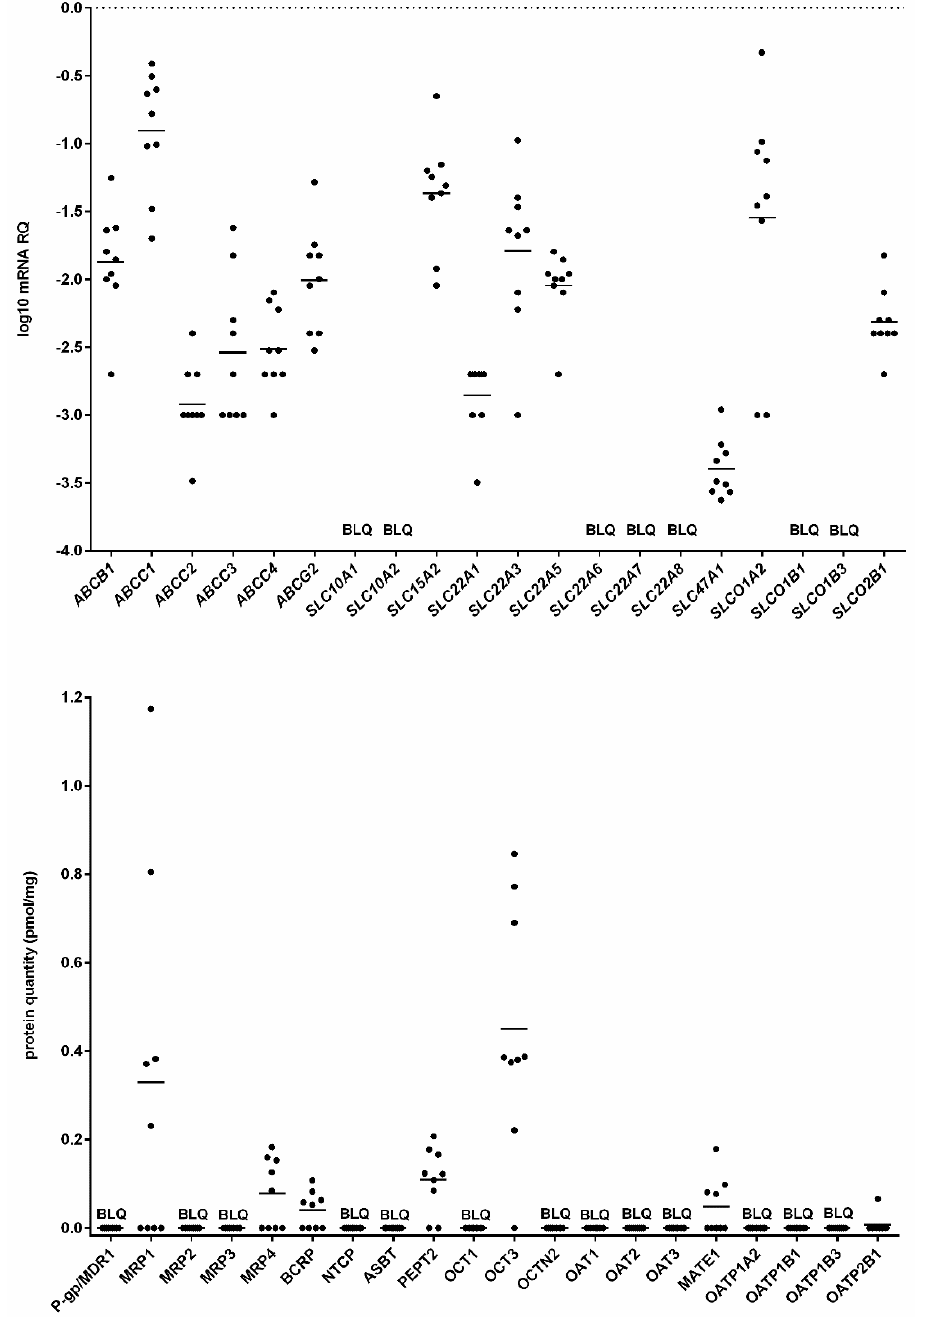
Figure 1. A scatter plot of the measured gene expression ( top ) and protein abundance ( bottom ) of ATP-binding cassette (ABC) and solute carrier (SLC) transporters in human parotid glands. Lines indicate population means of the sets of data. mRNA level (log-transformed values) of the analyzed genes was expressed as relative amounts to the mean of five housekeeping genes ( ACTB, GAPDH, PPIA, RPLP0, RPS9 ). BLQ—below quantification limit.